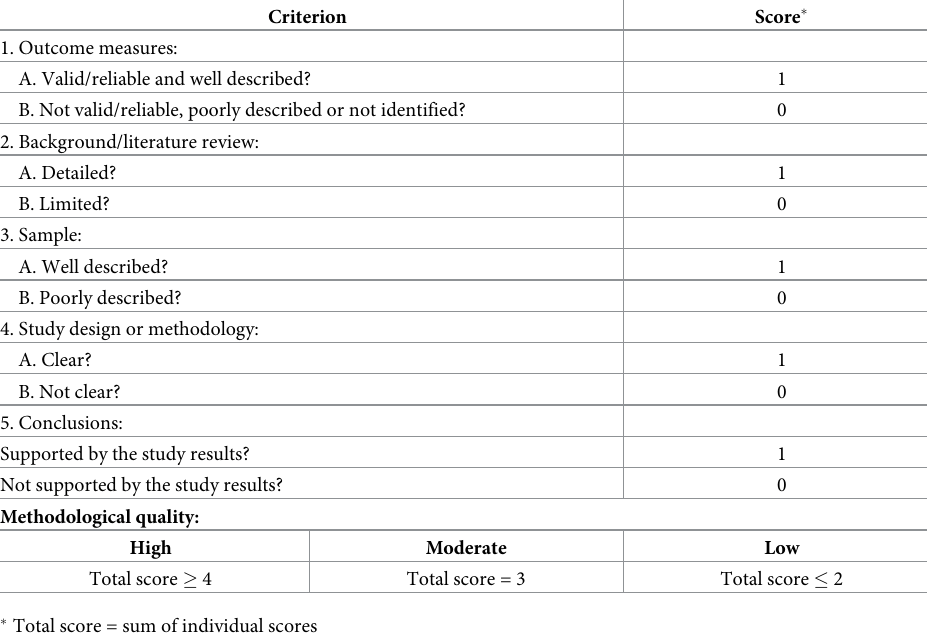
Table 3. Methodological quality appraisal